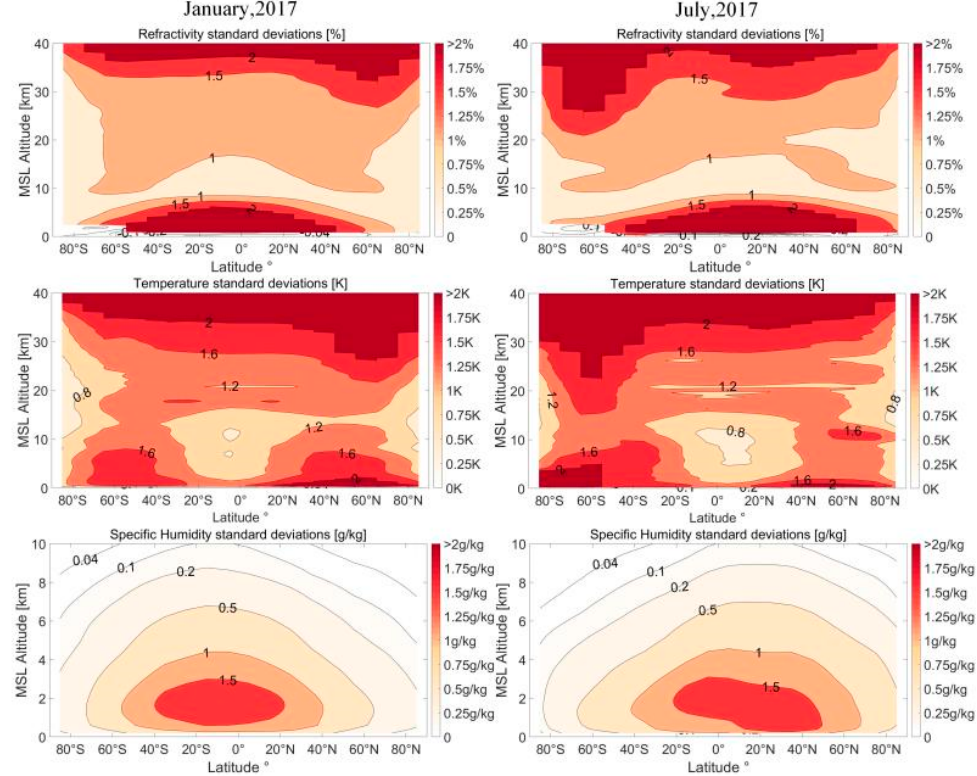
Figure 8. Latitudinal and altitudinal variations of standard deviations in refractivity (top panels), temperature (middle), and specific humidity (bottom) parameters in January and July of 2017 .